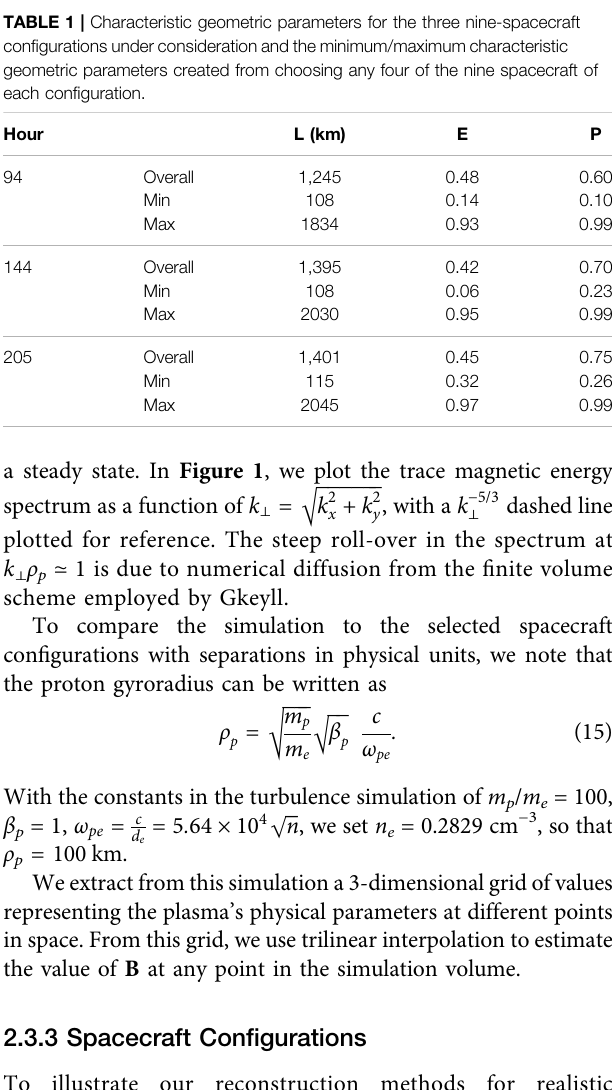
Frontiers in Astronomy and Space Sciences |